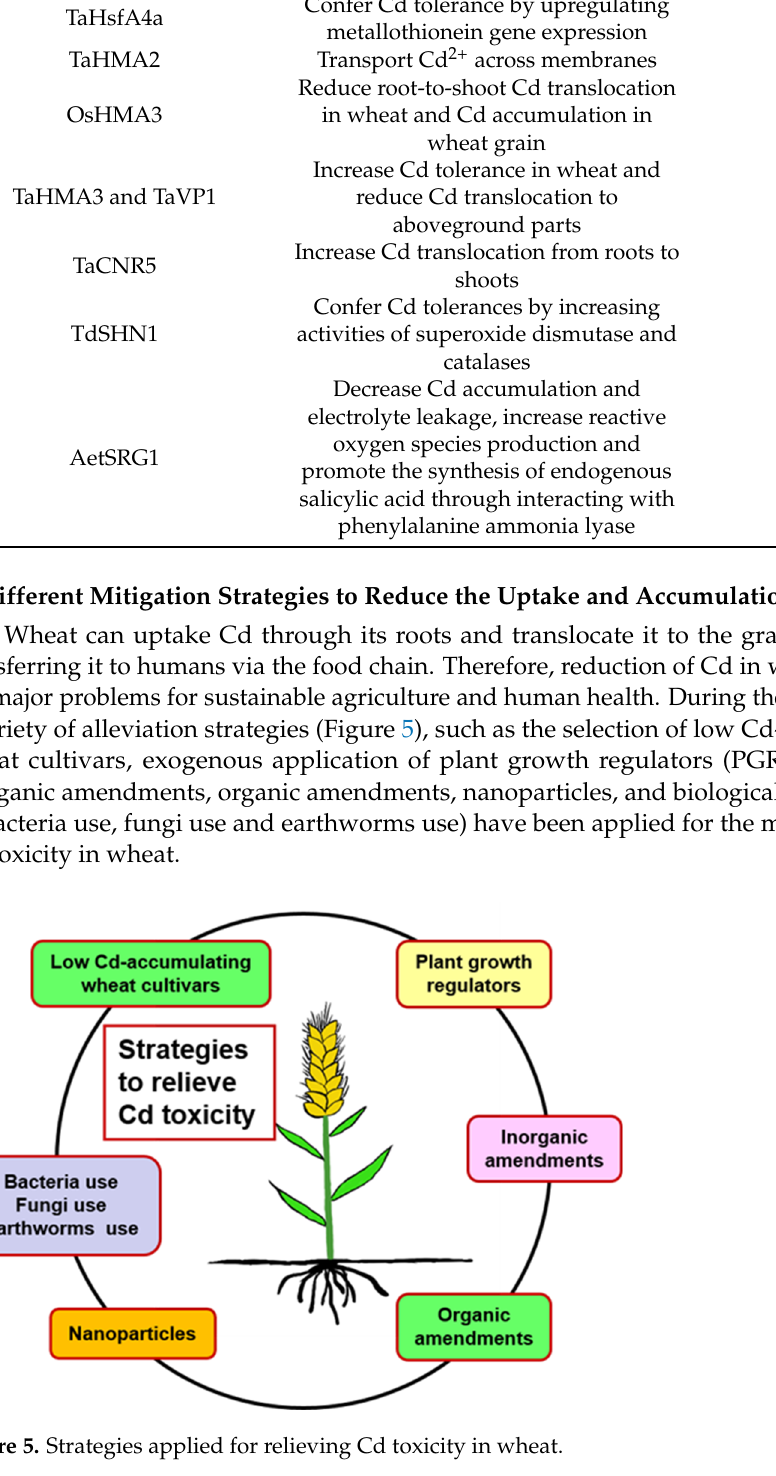
Table 3. Functional genes in wheat under Cd stress.